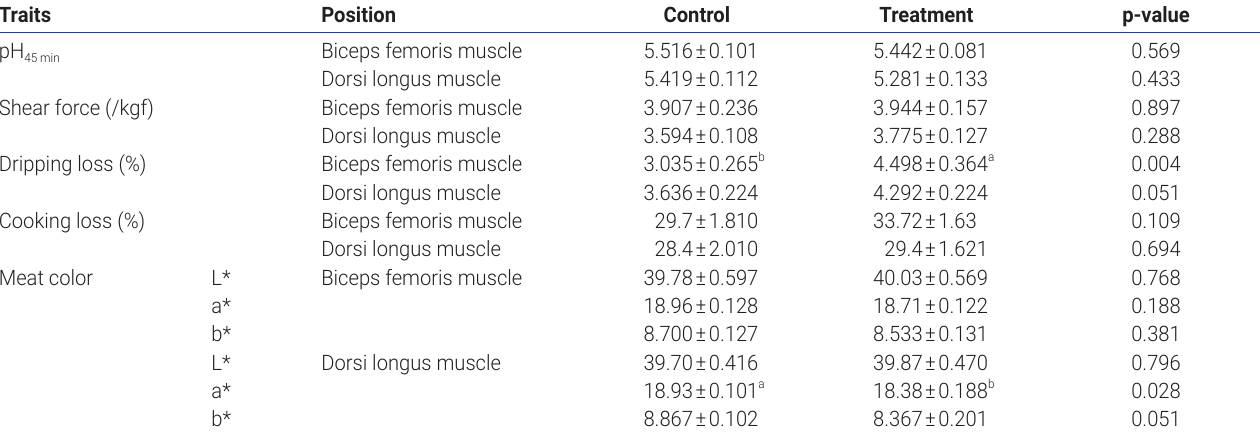
Table 6. Effects of prolonged photoperiod on fleshy characteristics of Jinjiang cattle Traits